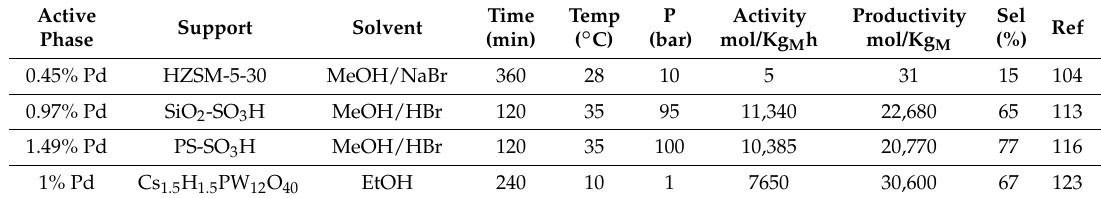
Table 3. The effect of the acidity of different supports on Pd catalysts.